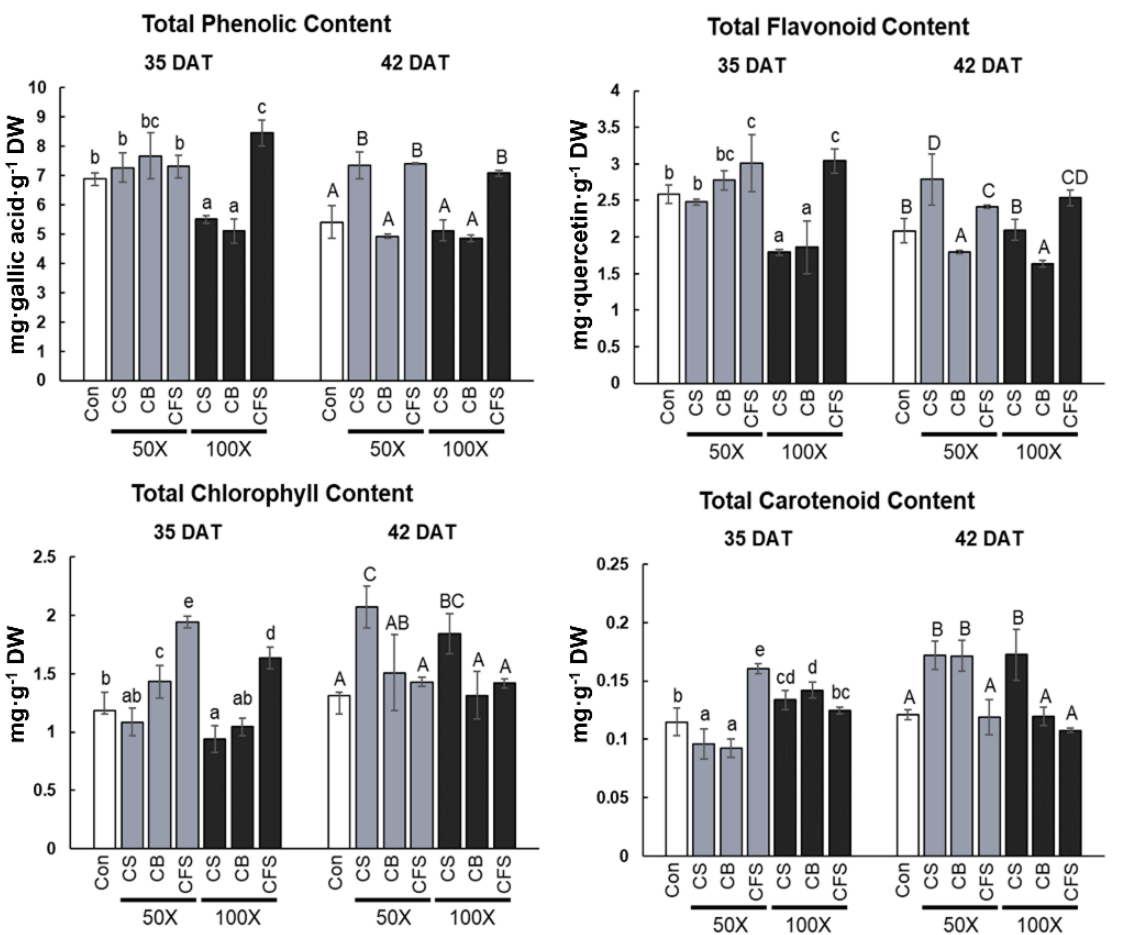
Figure 4. Phytochemical profiles of kale exposed to different Chlorella treatments. Bars represent the mean ± SD of three replicates. Different letters indicate significant differences at p < 0.05 based on Duncan’s multiple range tests. Con, distilled water; CS, Chlorella suspension; CB, Chlorella biomass; CFS, Chlorella − free supernatant; and DW, dry weight.